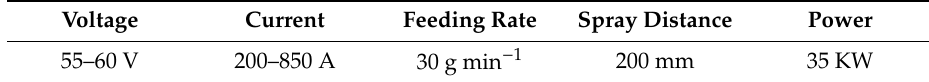
Table 1. Atmospheric plasma (APS) spraying parameters.